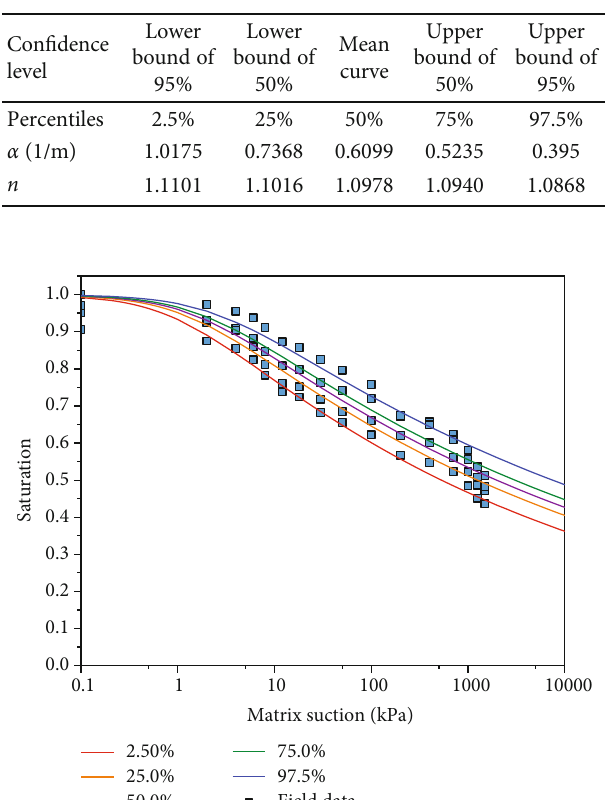
Figure 4: Iteration process of random samples of parameters α and n . Table 1: Di ff erent percentiles of parameters of the SWRC.